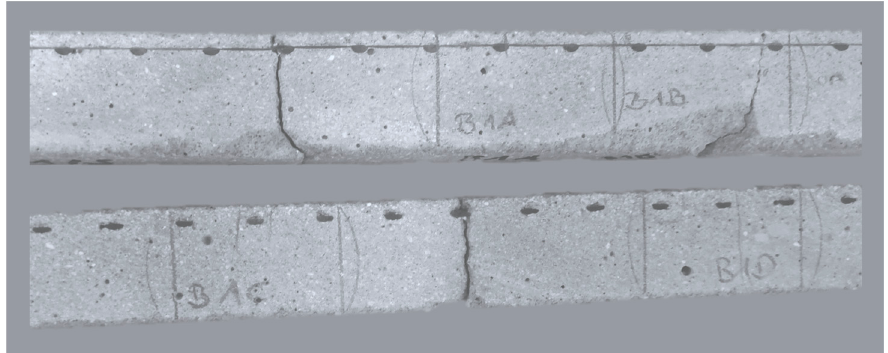
Figure 11. Cracked test specimen F1B.